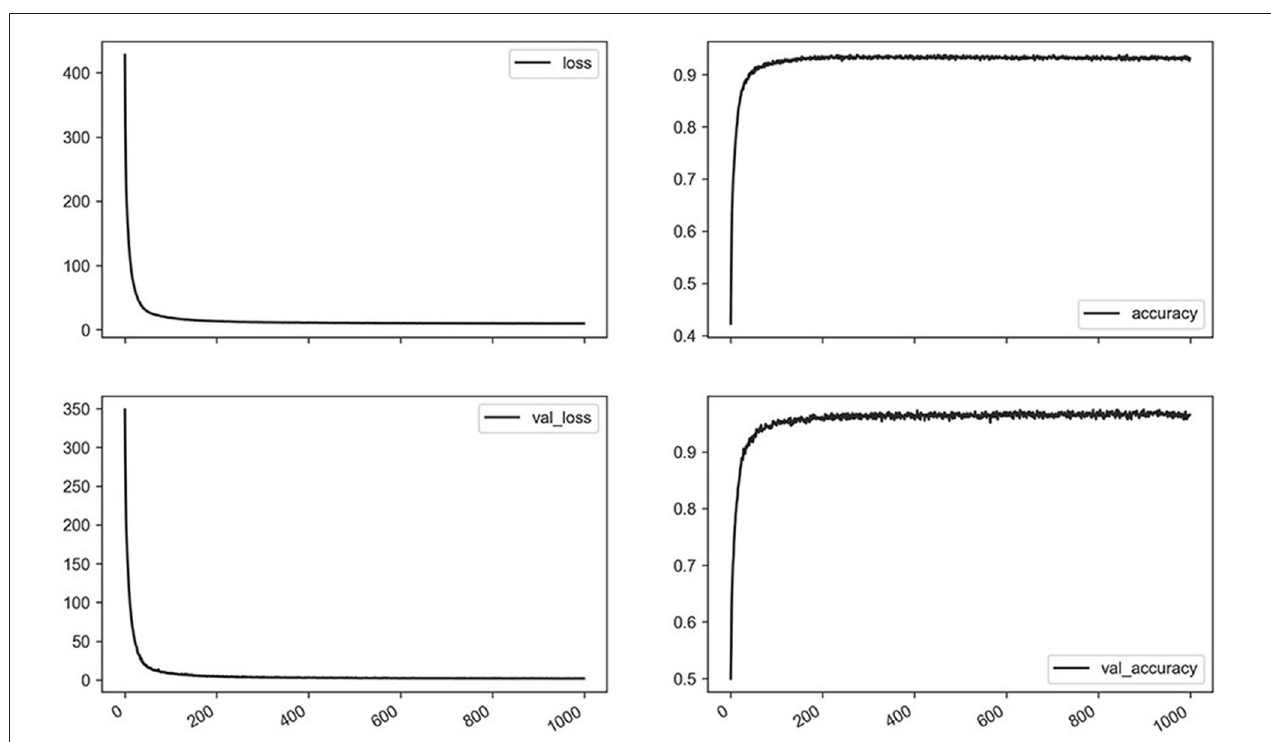
FIGURE 3 | Losses and accuracy of training for the representative network (bidirectional long short-term memory, two layers, 1,000 epochs) using a whole dataset.